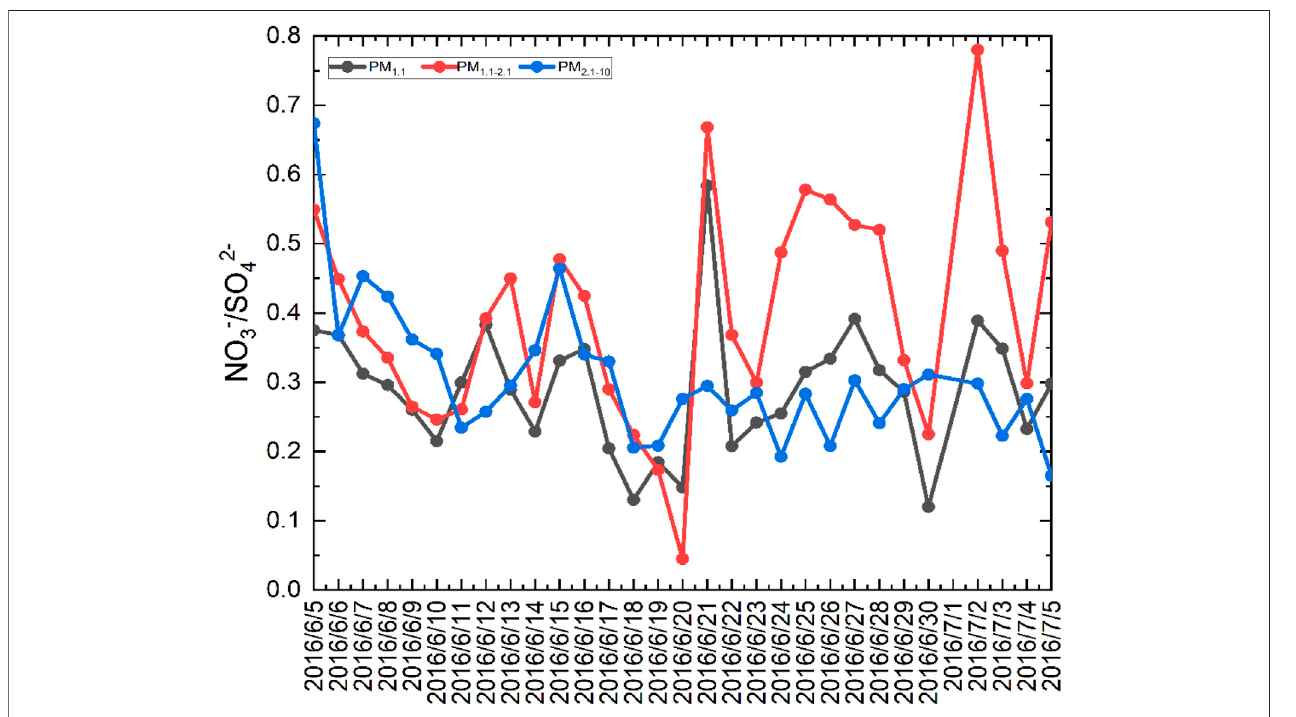
FIGURE 9 | Time series of NO 3 − /SO 42- in PM 1.1 , PM 1.1-2.1 , PM 2.1-10 during the sampling